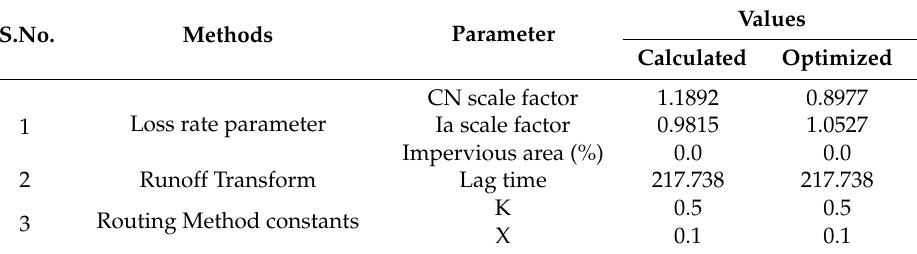
Table 4. Calculated and optimized parameters of the catchment.